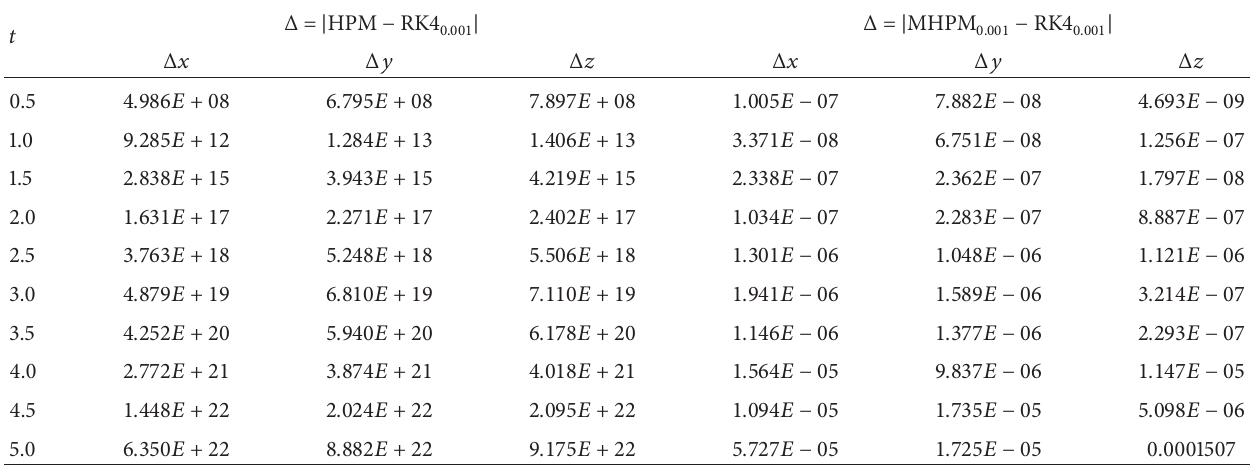
Table 5: Differences between 15-term HPM and 15-term MHPM with RK4 solutions for Δ𝑡 = 0.001 .